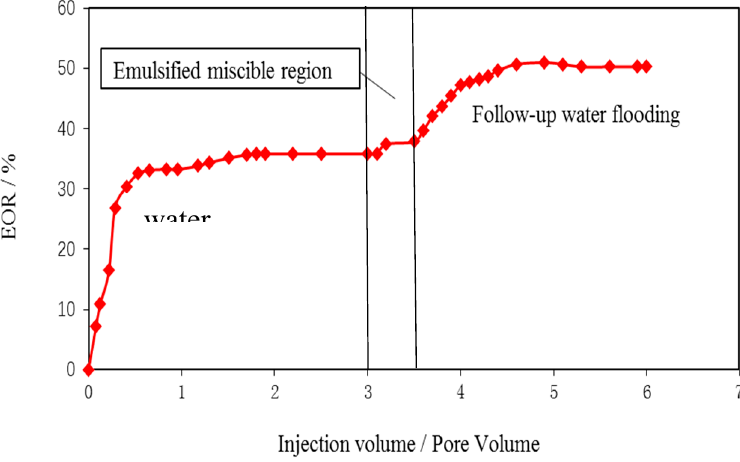
Rate. Figure 8. Relation Curve between Intelligent Polymer Flooding Agent Injection Rate and Recovery Rate.